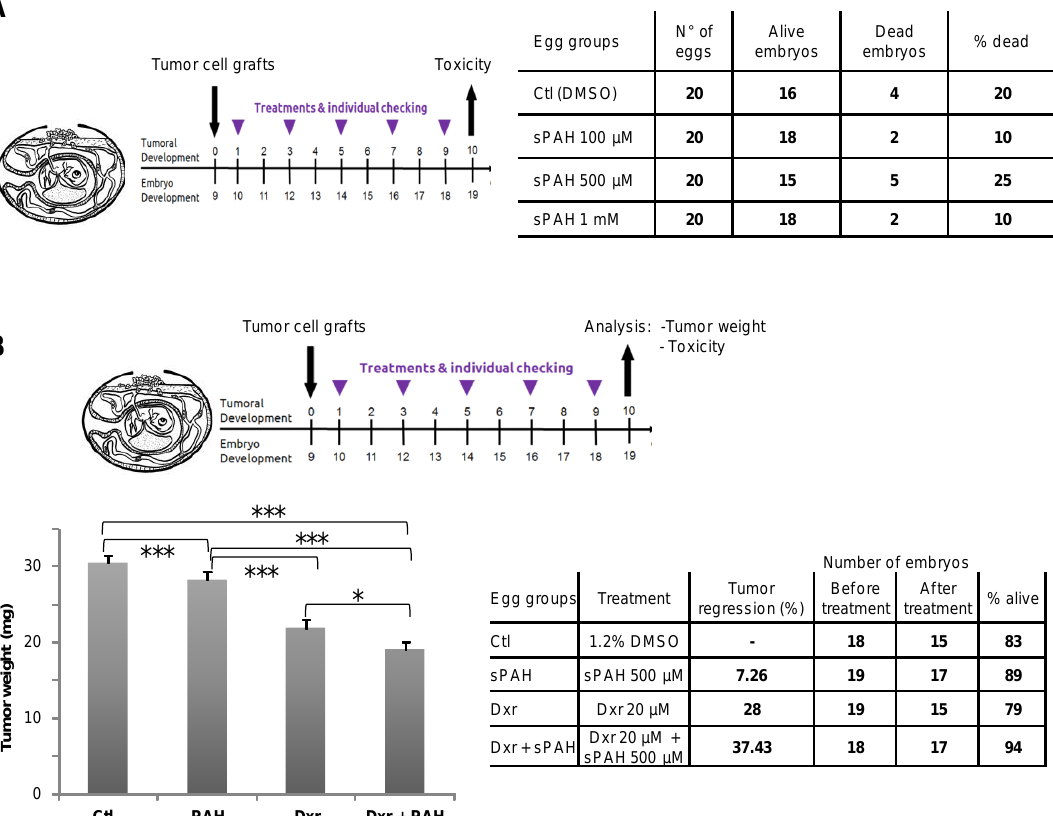
Figure 4. sPAH increases the efficacy of doxorubicin on melanoma cells xenografted in chick eggs without toxic effect. MeWo cells were grafted on the eggs chorioallantoic membrane (CAM). ( A ) Toxicity analysis. Chick embryos were treated with increasing doses of sPAH for 10 days. Then, the dead embryos were counted, and abnormalities were observed on surviving embryos. ( B ) Effect of the association sPAH and dxr on melanoma tumors. One day after inoculation of MeWo cells on the CAM, the tumors were treated by adding 100 µL of vehicle, dxr alone, sPAH alone or with dxr. After 10 days, the tumors were cut away from the CAM tissue and weighed. Significance: *: 0.05 ≥ p value > 0.01; ***: 0.001 ≥ p value; ns: no significant difference.